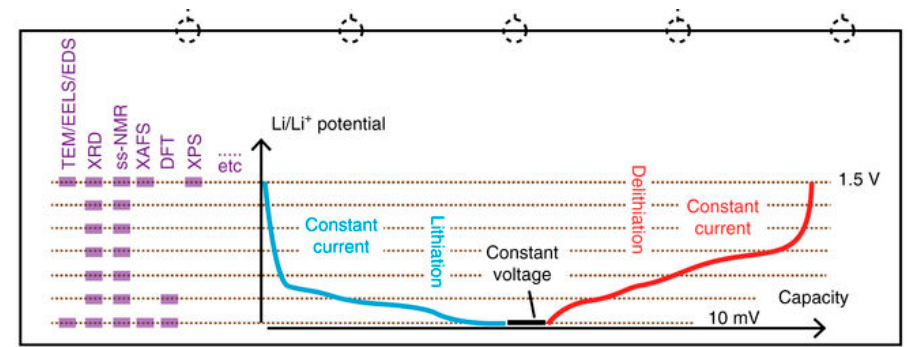
Figure 14. Overview of a structural characterization study conducted on spray-dried Si/C composites at different stages during individual cycles. The set of characterizations was repeated every 20